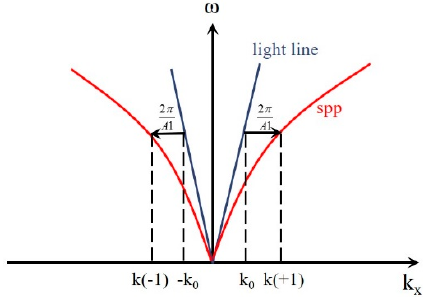
Figure 3. Wave vector matching